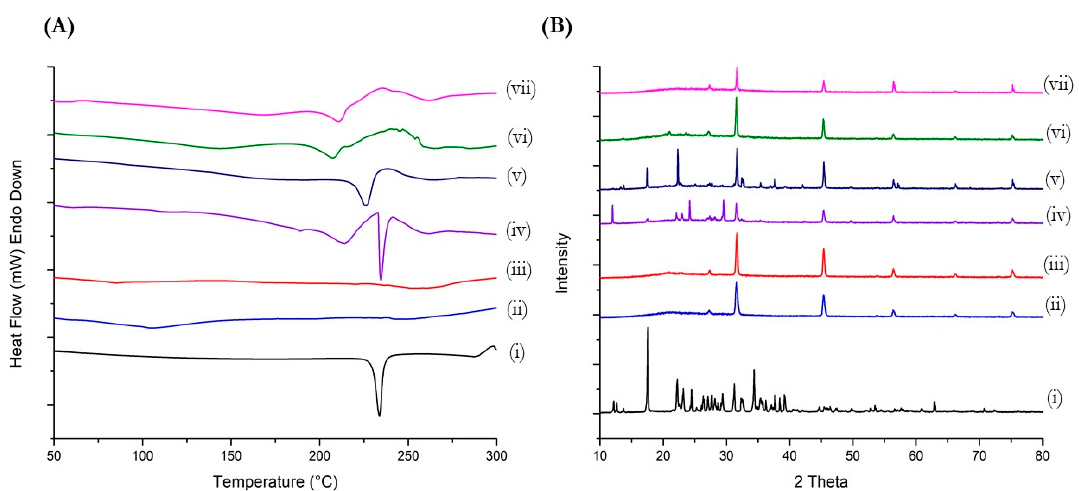
Figure 2. Characterization of optimized liposomal formulations performed using ( A ) Differential scanning calorimetry (DSC) and ( B ) Powder X-ray diffraction (PXRD) to confirm encapsulation of drug in liposomal vesicles. (i) Met hydrochloride; (ii) blank ND lipo; (iii) blank DO lipo; (iv) physical mixture of blank ND lipo and Met; (v) physical mixture of blank DO lipo and Met; (vi) Met ND lipo; and (vii) Met DO lipo.